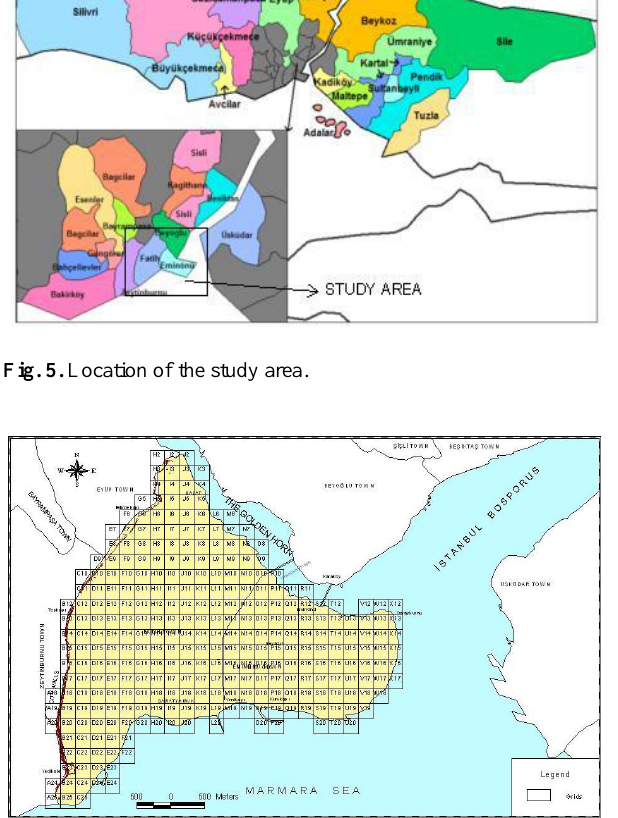
Figure 6. Dividing cells in the study area (250*250m) (İnce, 2005) Fig. 6. Dividing cells in the study area (250 × 250m) (˙Ince,